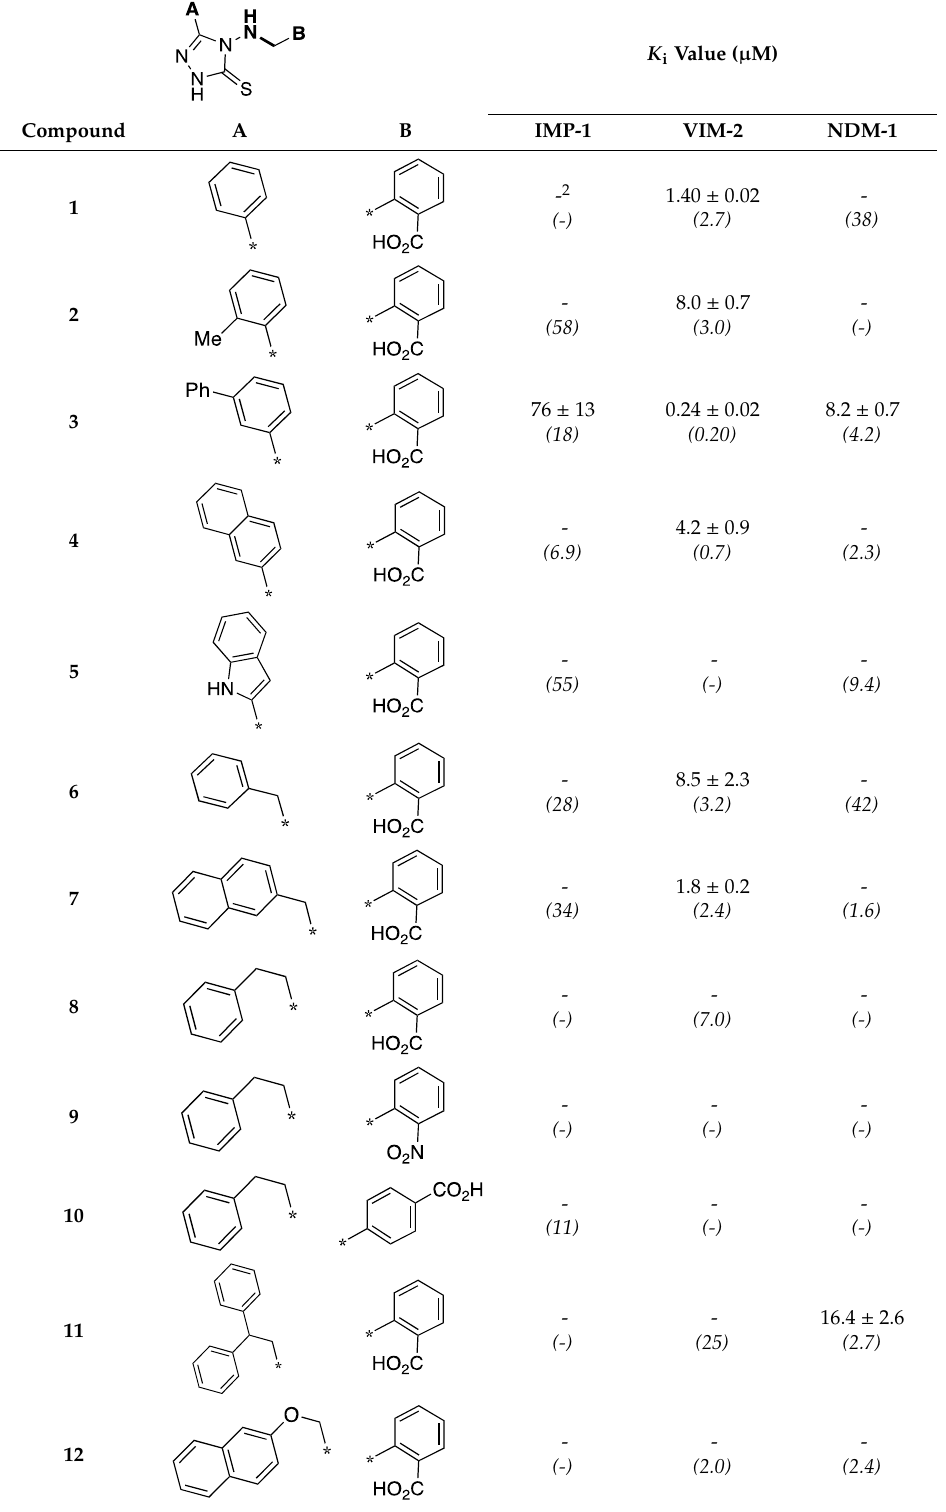
Table 1. Inhibitory potencies of compounds 1 – 12 of the hydrazine series against representative MBLs 1 .